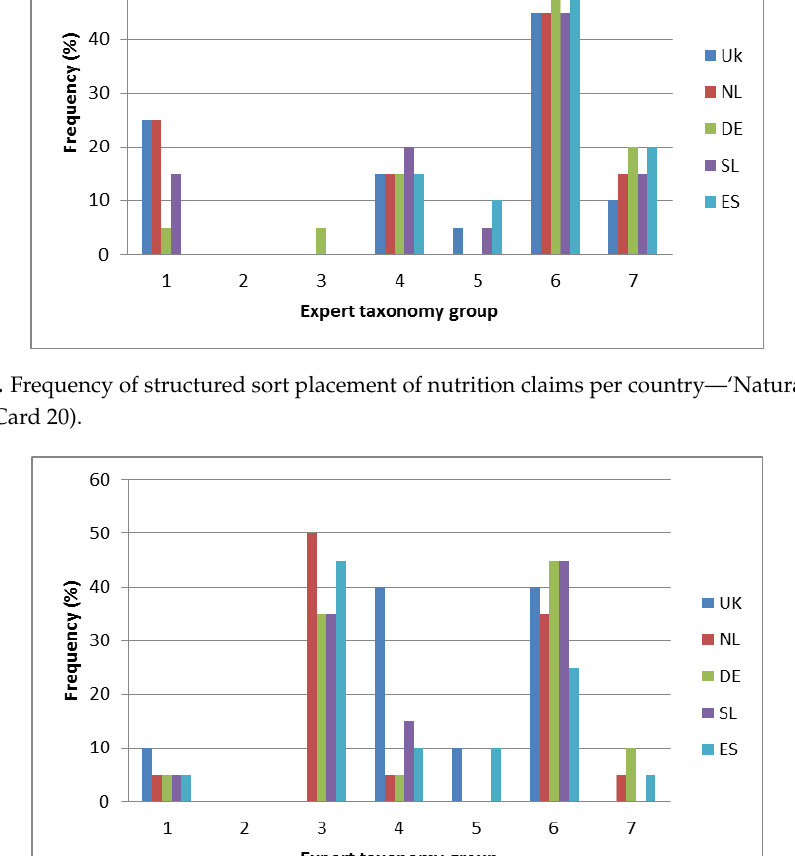
Figure A3. Frequency of structured sort placement of nutrition claims per country—‘Fat-free’ (Card 21).